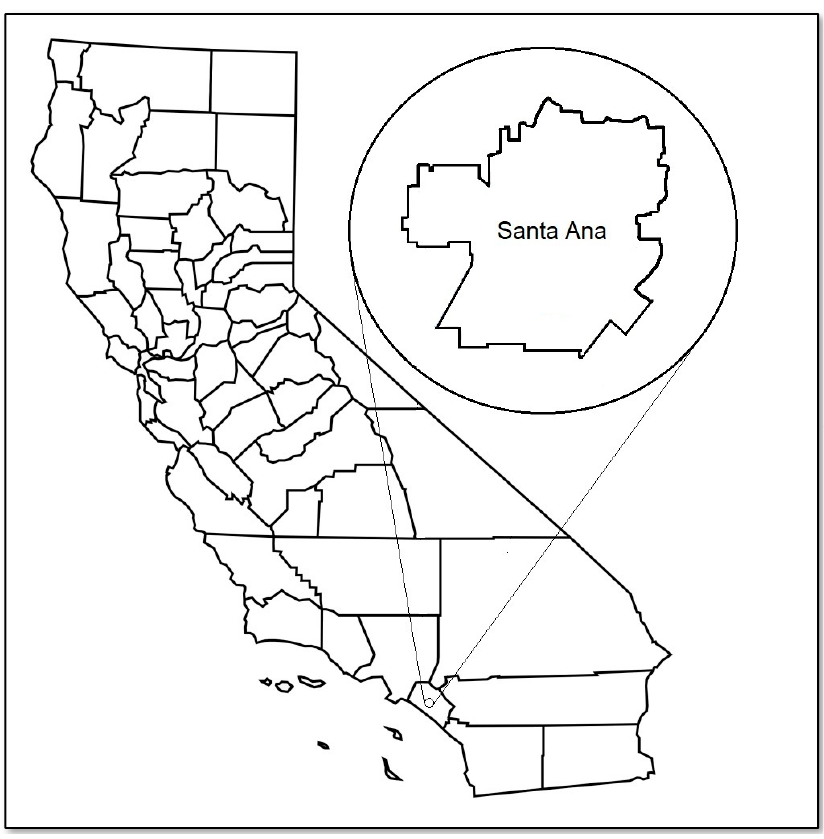
Figure 1. Map depicting the city of Santa Ana within California.